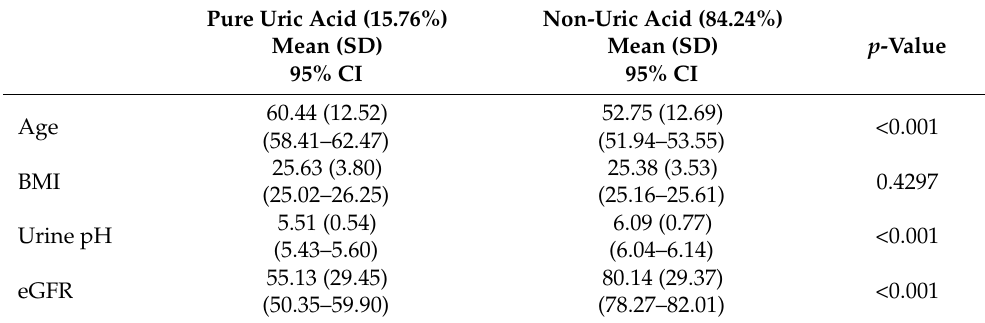
Table 2. Age, BMI, urine pH, and eGFR of all study samples in Cohort A. Pure Uric Acid